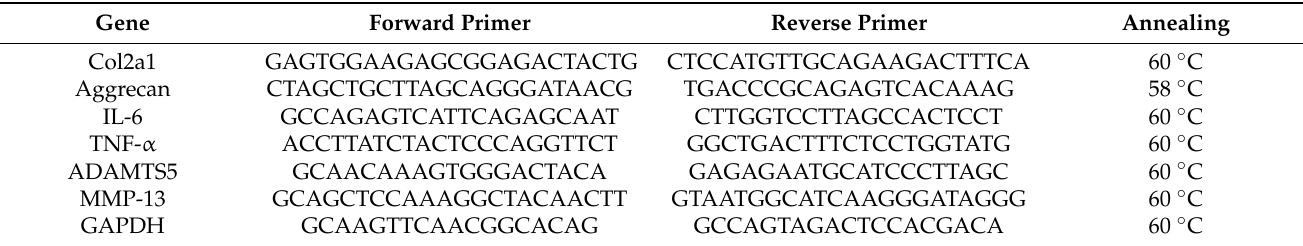
Table 1. Primer used for real-time polymerase chain